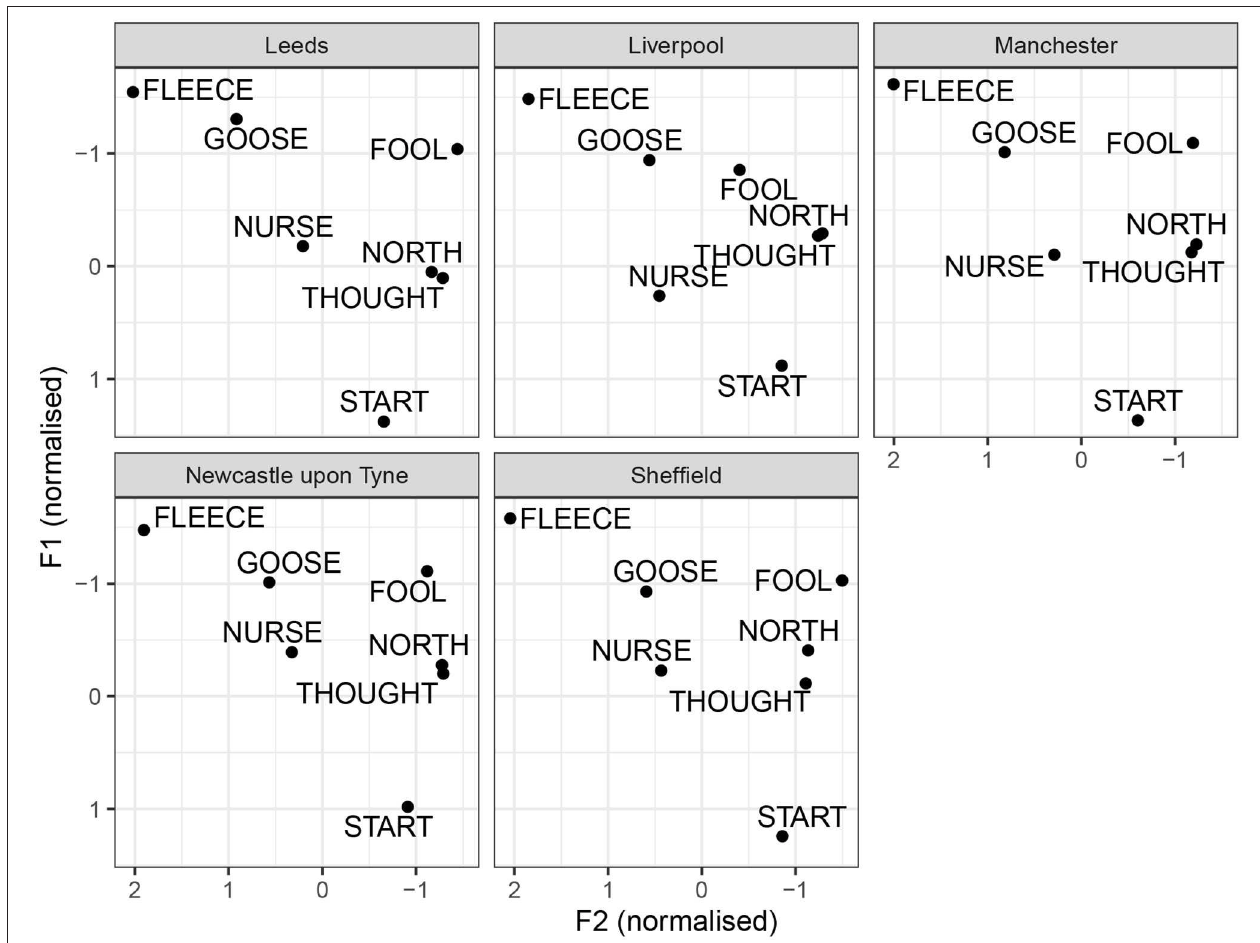
FIGURE 5 | By-city tense vowel